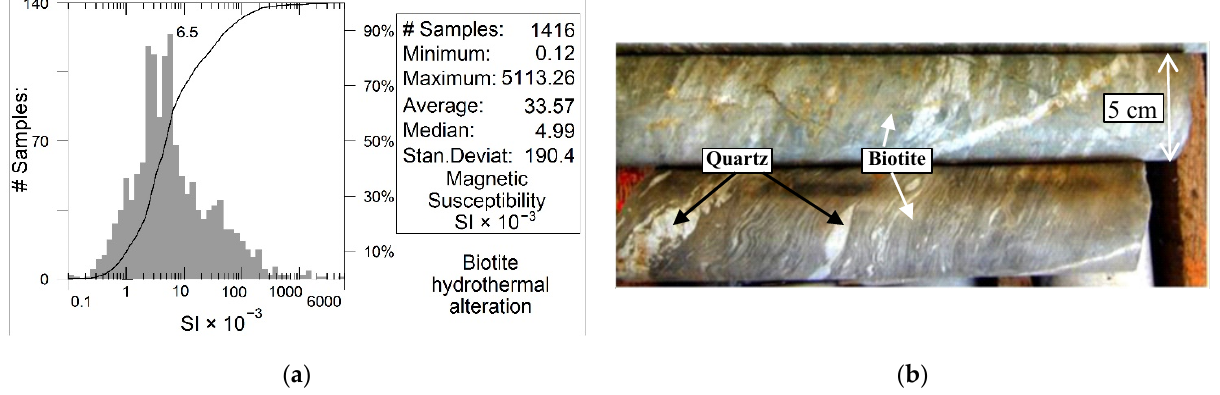
( b ) Figure 16. S ilicification zone. ( a ) Statistics and histogram of the magnetic susceptibility measurements. ( b ) Core sample picture. The presence of paramagnetic minerals and instrumental limitations to measure negative values justifies the low positive susceptibility values. In the drill cores, an abundance of silicification is closely related to the low- to high-grade mineralization